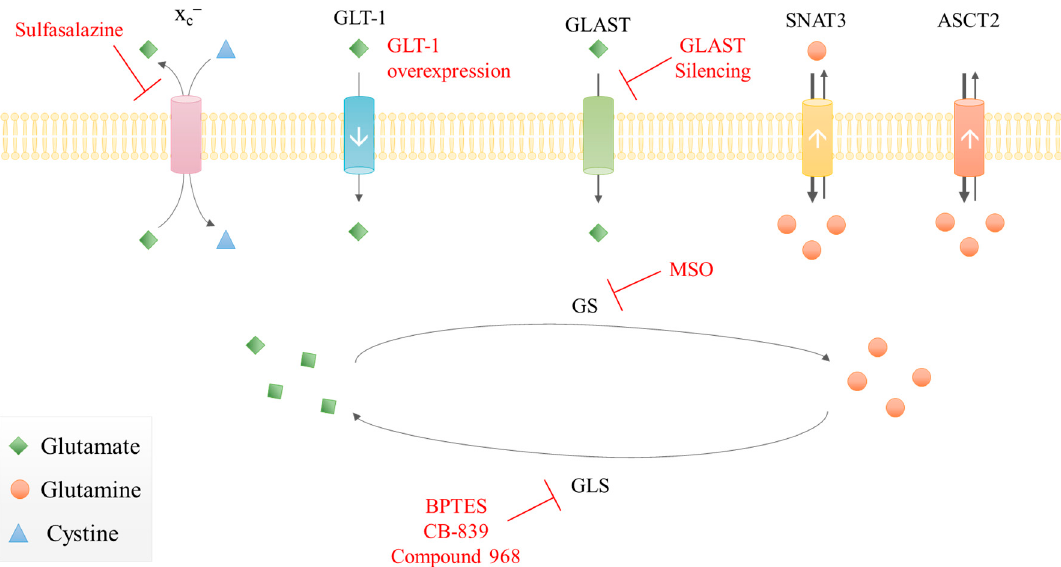
Figure 3. Therapeutic approaches targeting glutamate-glutamine metabolism in malignant gliomas. Summarization of some putative targets and drugs (red) in glioma cells: inhibition of glutaminase (GLS); inhibition of glutamine synthetase (GS); x c – inhibition; GLT-1 overexpression; GLAST silencing. White arrows represent the transporters’ expression level in gliomas: down arrow corresponds to lower expression; up arrow is overexpression.